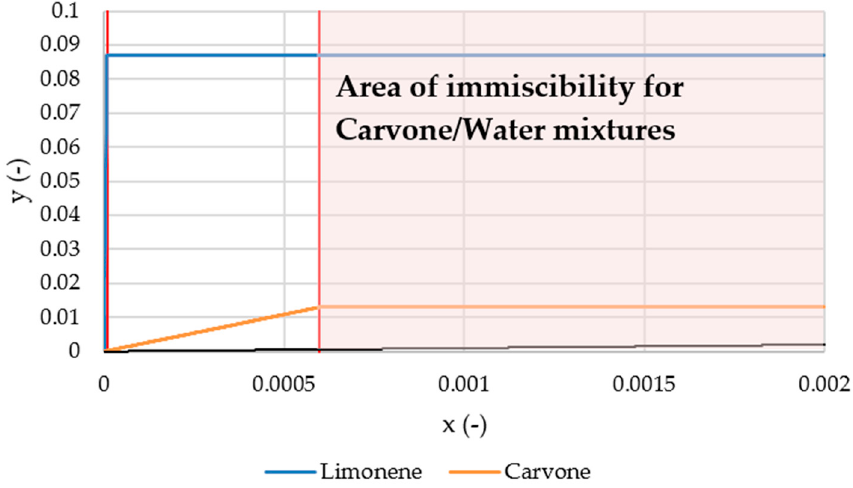
Figure 13. Vapour–liquid equilibrium diagram of the caraway system.